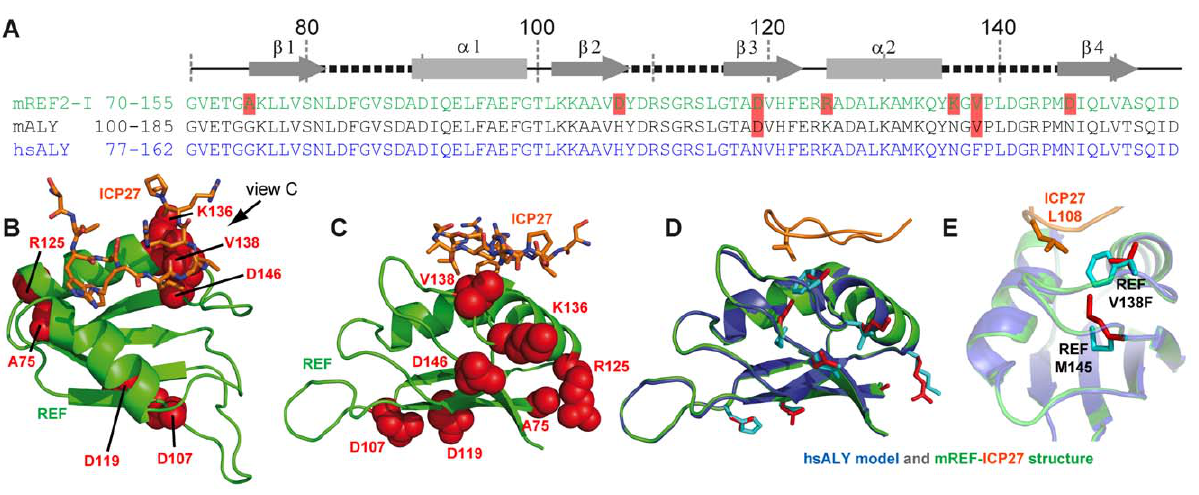
Figure 5. Modelling of complex between human Aly and HSV-ICP27. (A) Sequence alignment of RRM domains of murine REF2-I (mREF2-I: CAB76384) used in this study, murine Aly (mALY: AAC53117) and human Aly (hALY: AAD09608). Position of secondary structure elements ( b -sheets, a - helices and loops) is shown in relation to the REF2-I. Resides in mALY and mREF2-I that differ from hALY are highlighted in light red. (B) A cartoon of the structure of REF-ICP27 with the position of the 7 amino acid differences indicated using red space-fill spheres, this orientation shown is the same as used in Fig. 3, whereas in (C) an alternative orientation is used for clarity. Only one amino acid difference is part of the ICP27 interaction site, namely Val138 of mREF2-I, which is a Phe in hALY. (D) A model of hsALY (blue) overlaid with the experimental structure of mREF2-I (green), with ICP27 also shown (orange). Residues that differ between the RRM domains of mREF2-I and hsALY are red sticks in the mREF2-I form and cyan sticks in hsALY. The sidechain of M145 altered in the modelling procedure is indicated by sticks. Also the ICP27 sidechain of L108 is indicated (orange) which is positioned within the hydrophobic pocket of REF. (E) Detailed view of the sidechains of Met 145, and Val138 and Phe138 in the modelled hsALY (blue) and experimental REF2-I (green) structures, plus L108 of ICP27 is shown (orange).